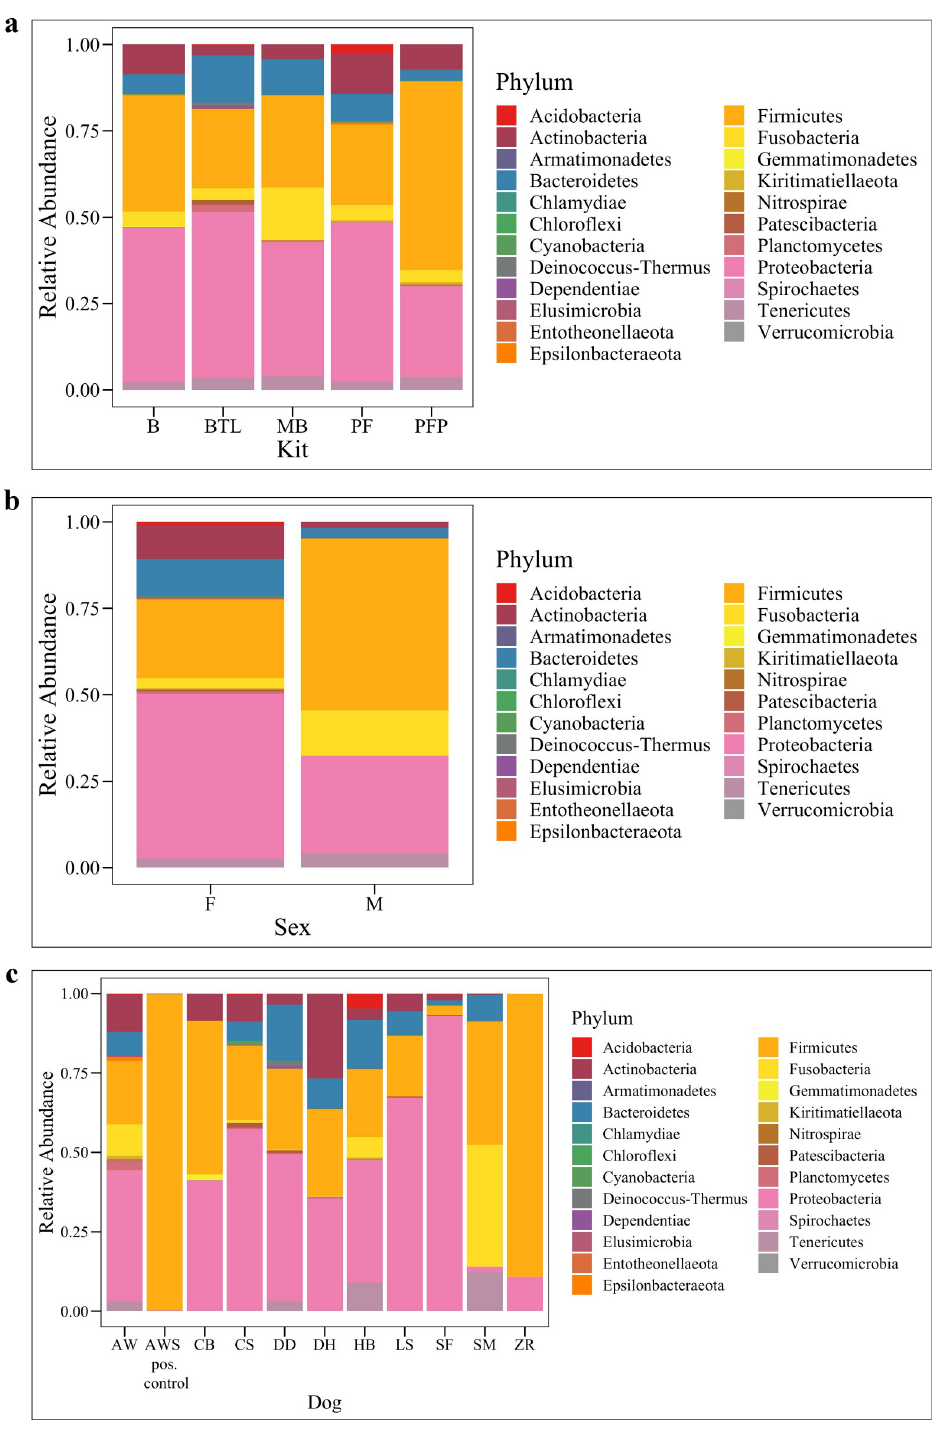
Fig 5. Bacterial relative abundances by phyla. Bacterial taxa bar plots by Phyla for ( a ) extraction method, ( b ) sex and ( c ) dog. B = Bacteremia, BTL = Blood Tissue with Lysozyme, MB = Magnetic Beads, PF = PowerFecal 1 , PFP = PowerFecal 1 Pro, F = Female, M =